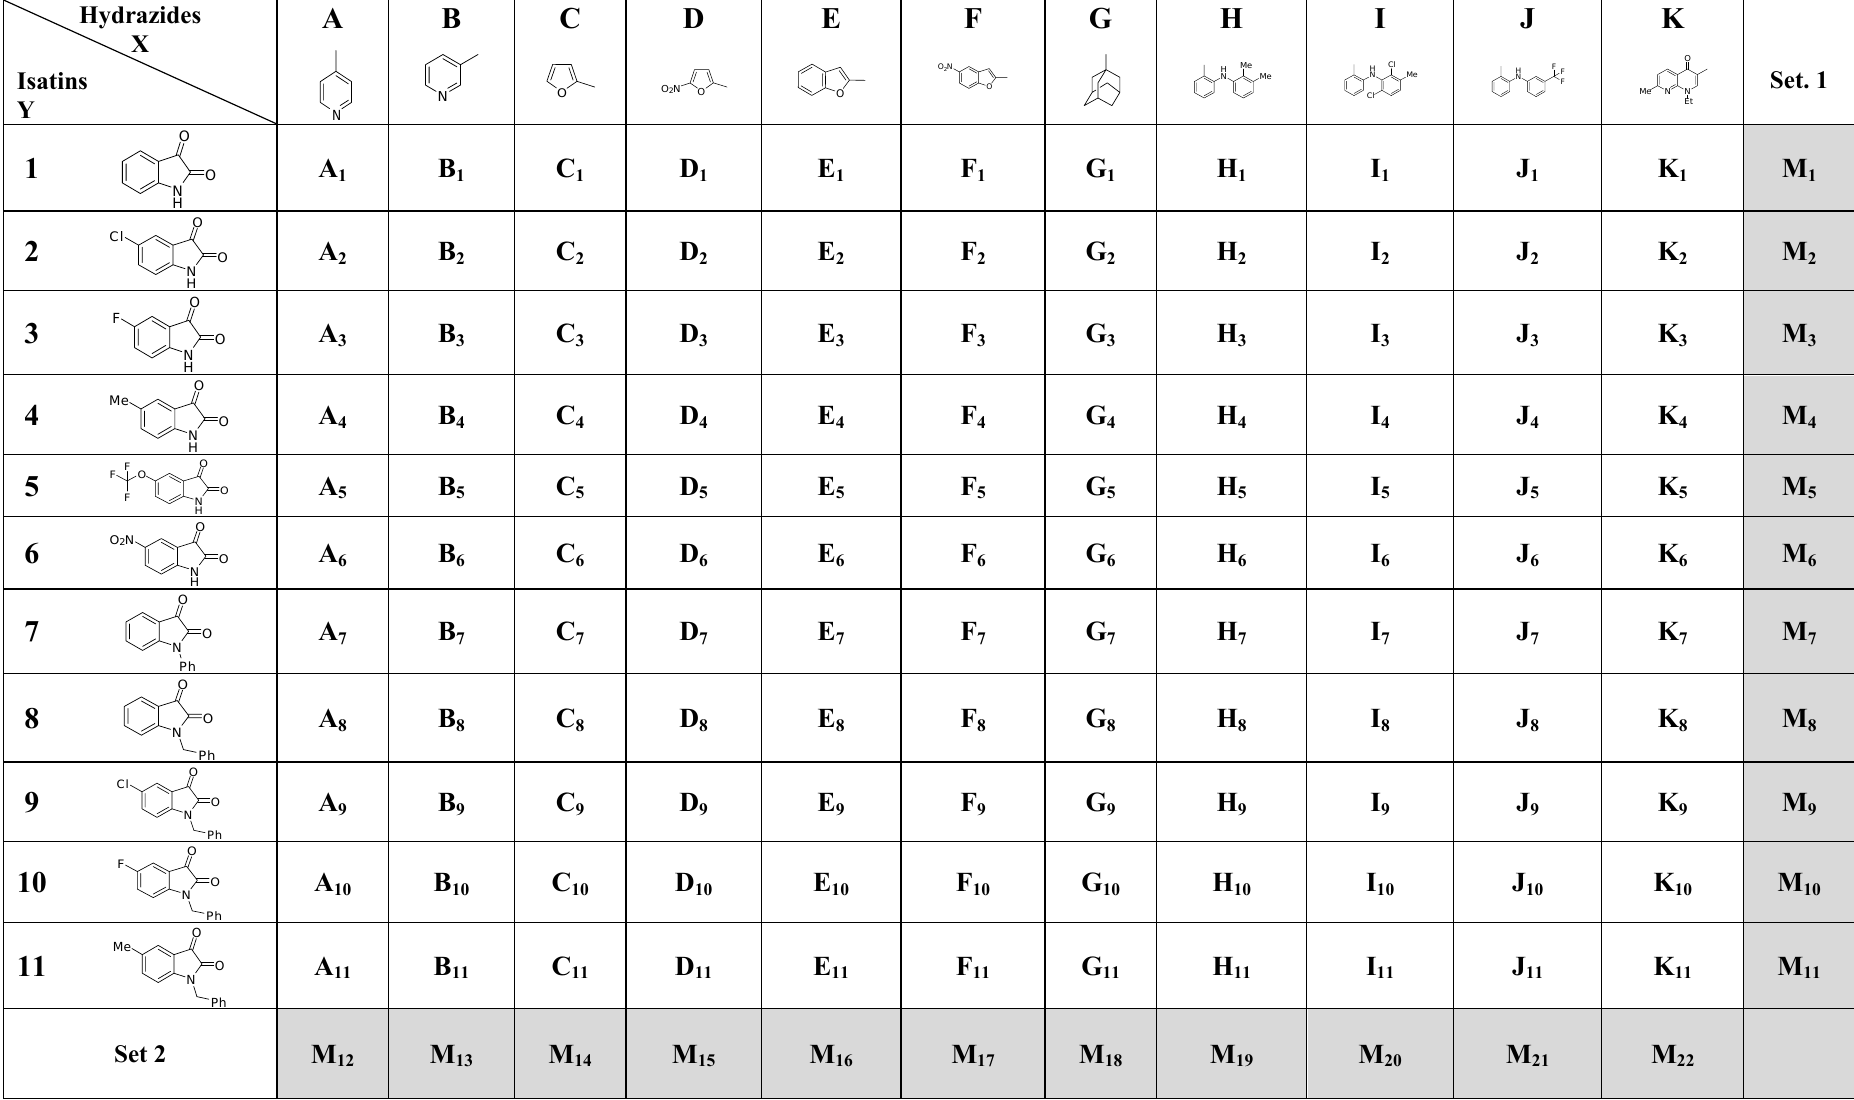
Table 1. Building blocks and the designed Schiff bases combinatorial